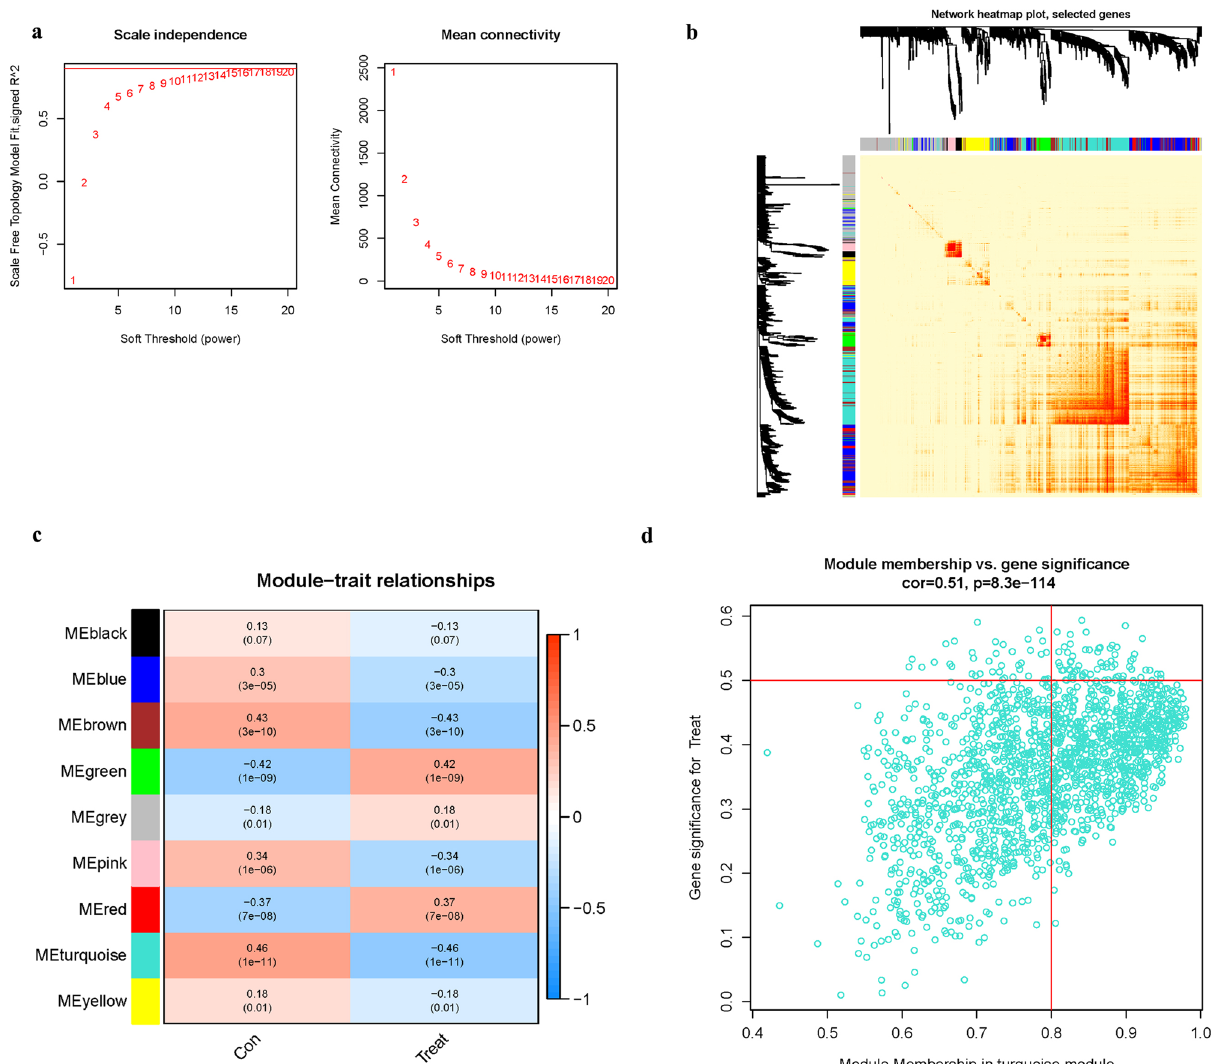
distinct modules using hierarchical clustering with a threshold of 0.25. Each color represents a separate module. ( c ) Heatmap of correlations between module eigengenes and clinical characteristics. ( d ) Gene scatterplot in the turquoise